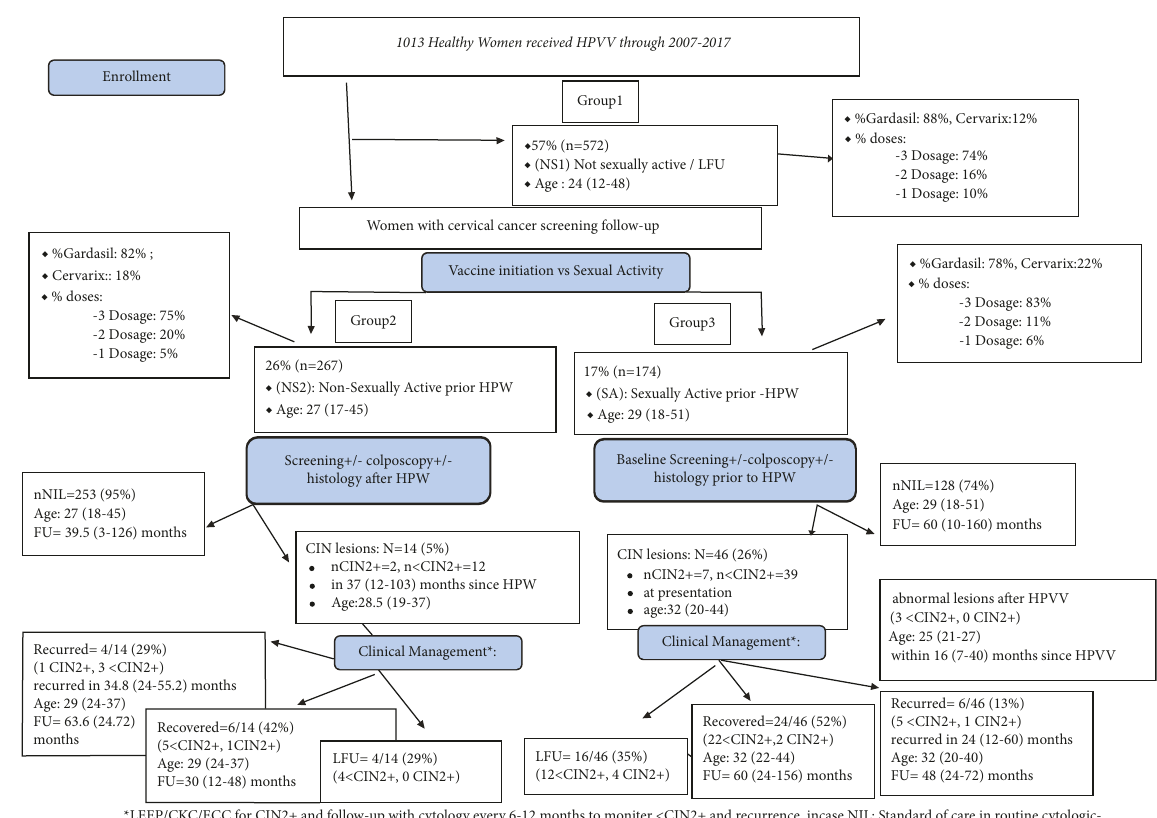
Figure 1: Follow-up of women who received the human papilloma virus vaccine at the Women’s Health Center (WHC) of the American University of Beirut-Medical Center (AUBMC) 2007–2017. Table 3: Recurrence of CIN lesions in women who received the human papilloma virus vaccine at the Women’s Health Center (WHC) of the American University of Beirut-Medical Center (AUBMC) 2007–2017. Outcomes of lesions p Value Relative risk for recurrence CIN2+ CIN2+ < CIN2+